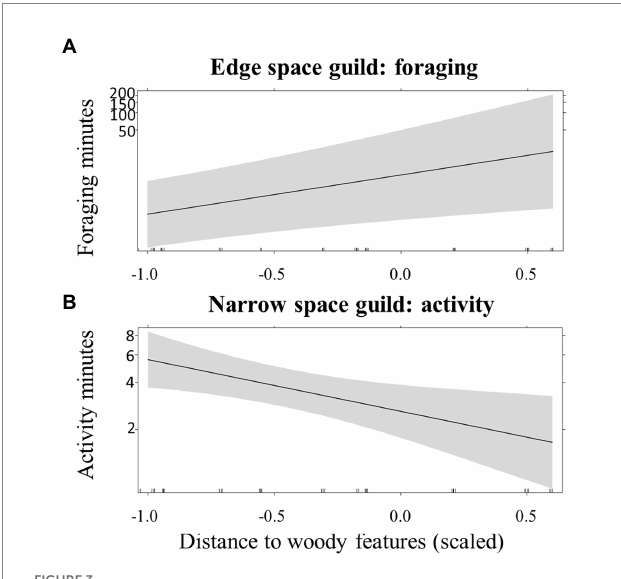
FIGURE 3 Effect plot for the predicted effects of distance to woody features (scaled) on (A) edge space guild foraging and (B) narrow space guild